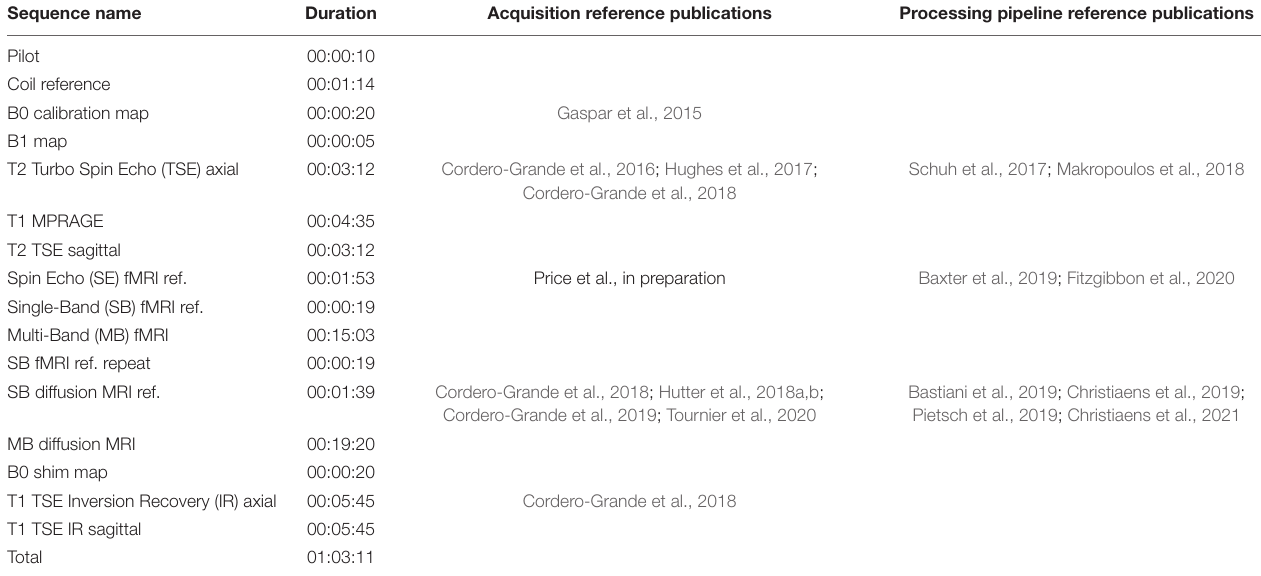
TABLE 1 | Neonatal imaging protocol, lasting a total of 1 h 3 min 11